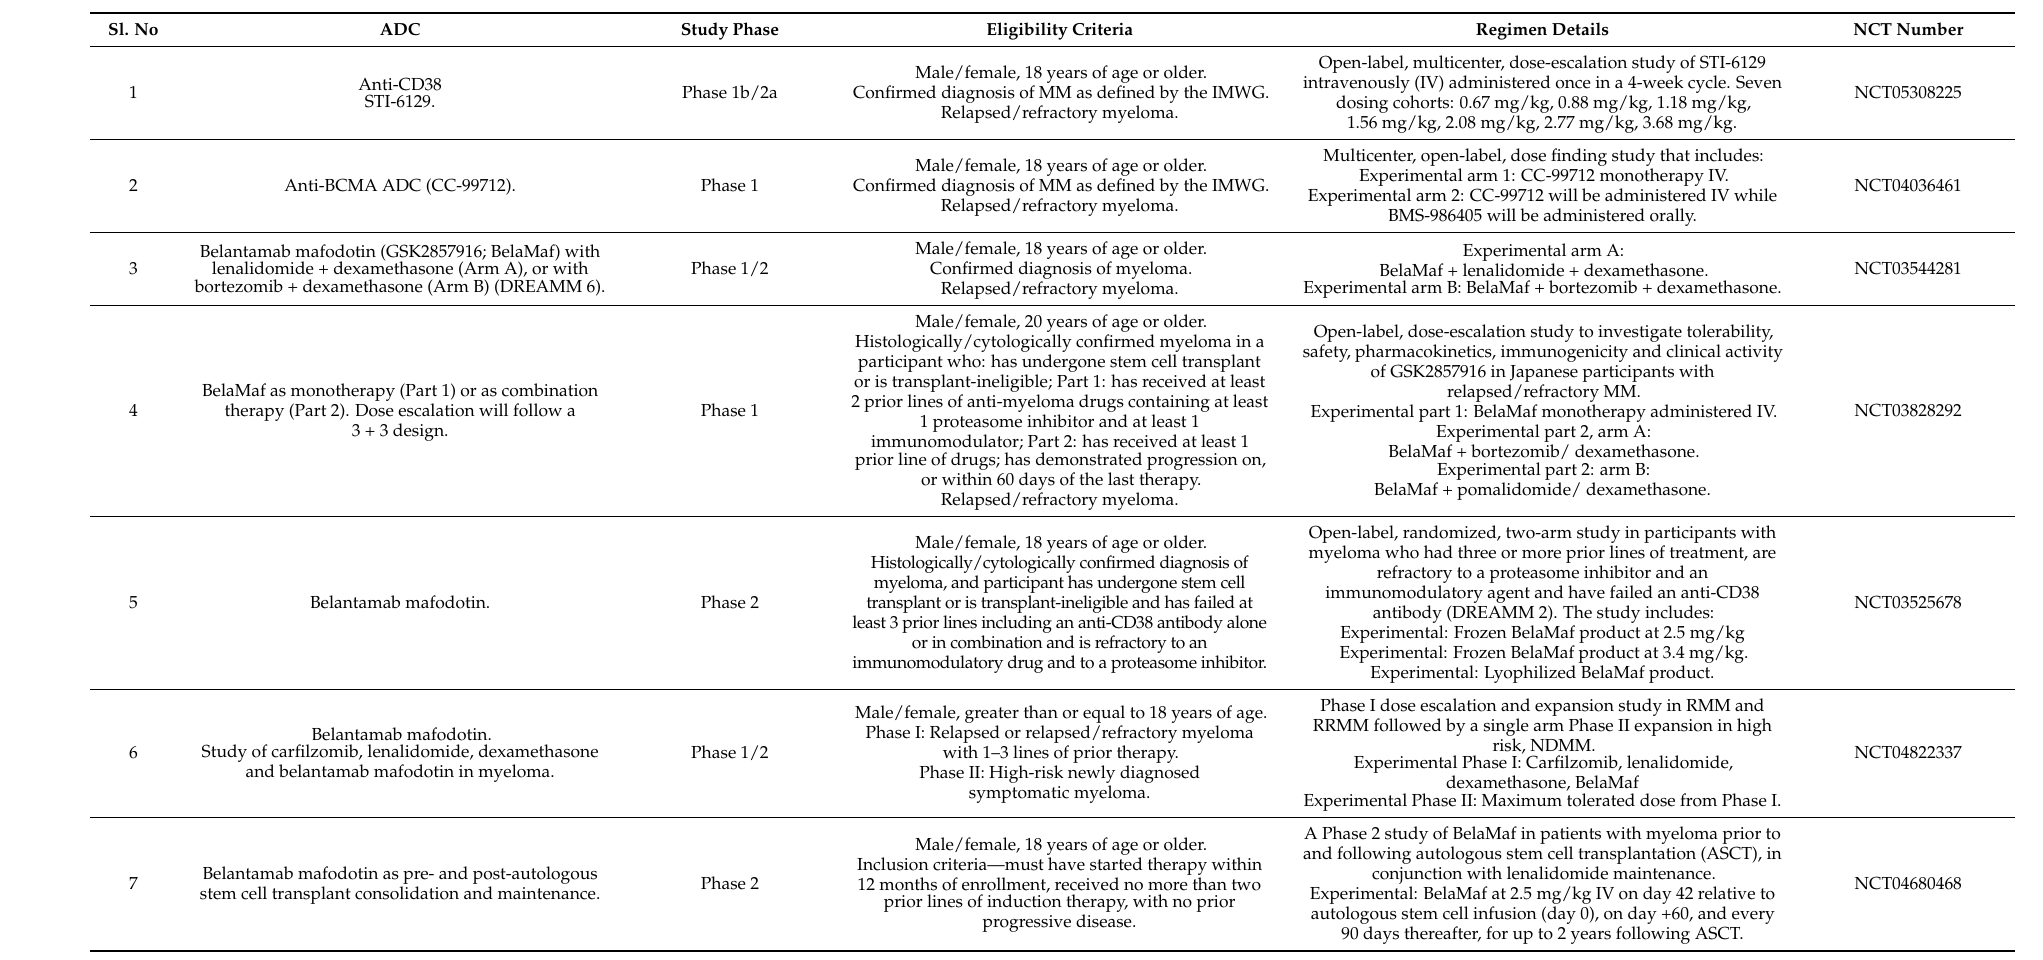
Table 2. Currently Active Clinical Trials of Antibody–Drug Conjugates in Multiple